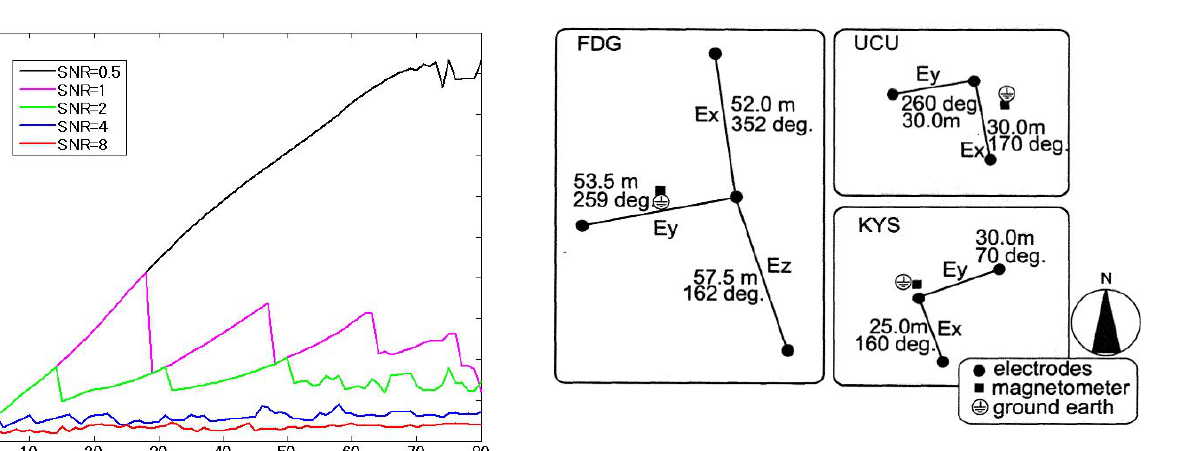
Fig. 13. Configuration of KYS , UCU, and FDG